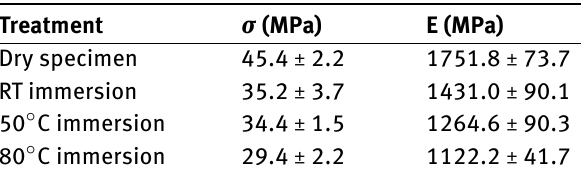
Table 1: Tensile Properties of The Composites with Varying Immer- sion